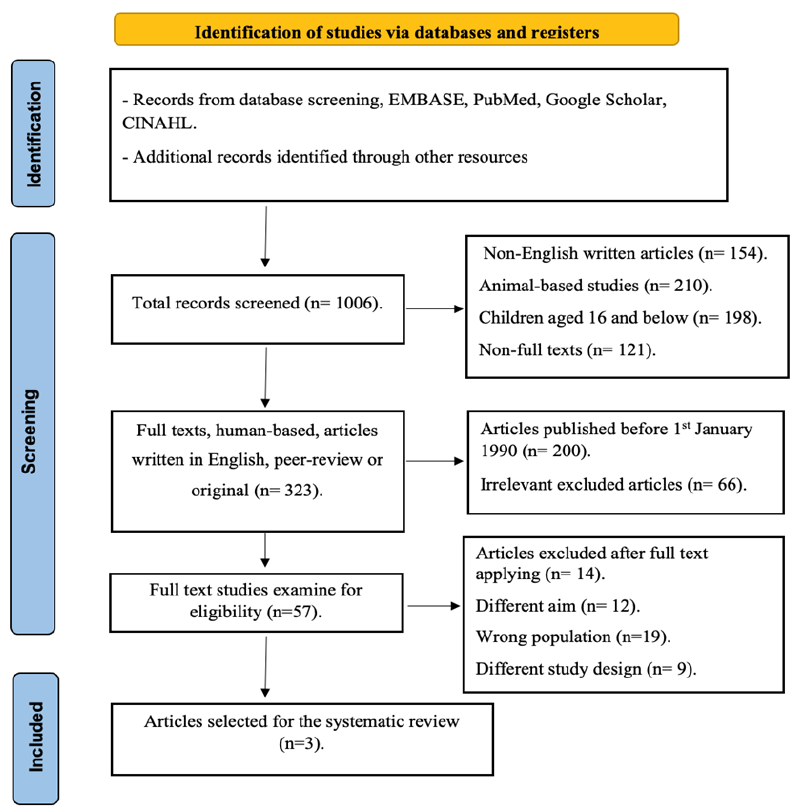
Figure 1. PRISMA flowchart of the screening process.